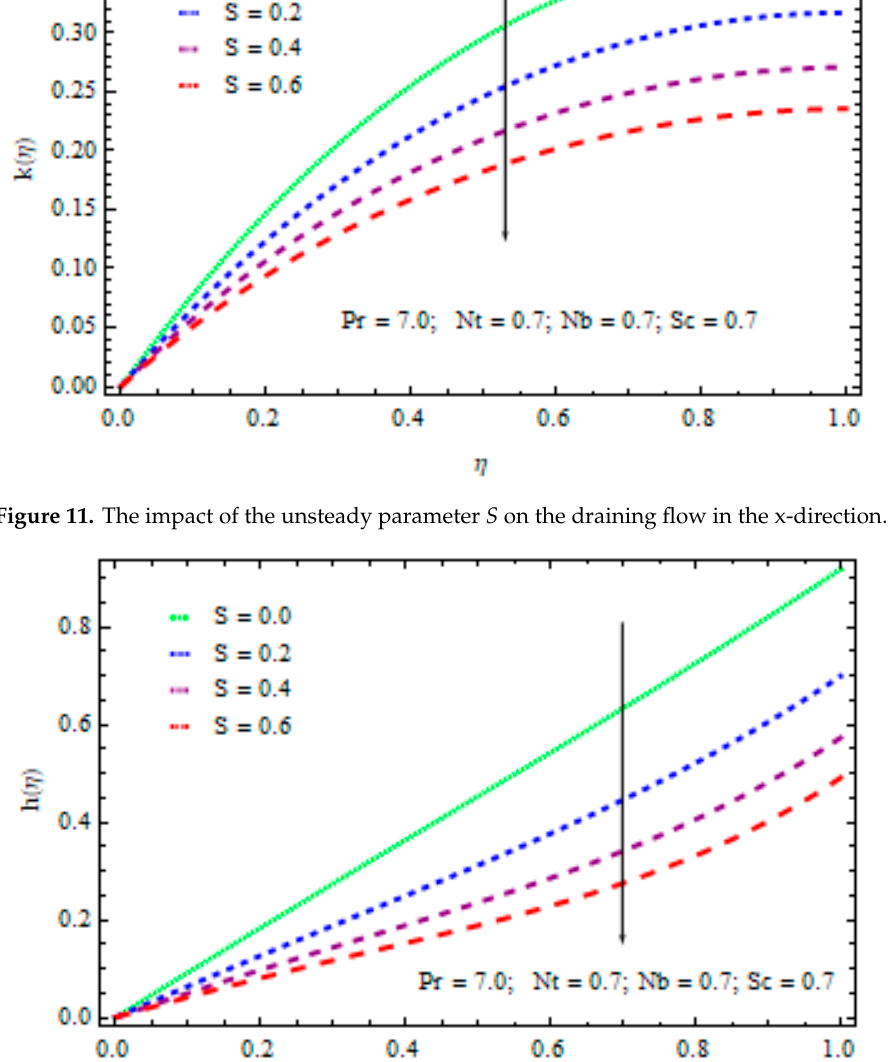
Figure 12. The impact of the unsteady parameter S on the induced flow in the y-direction.